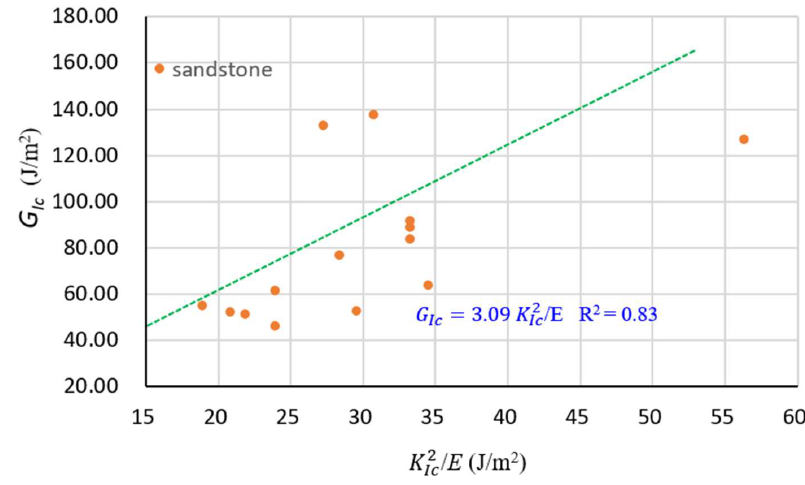
Figure 6. Regression equation and data of sandstone.